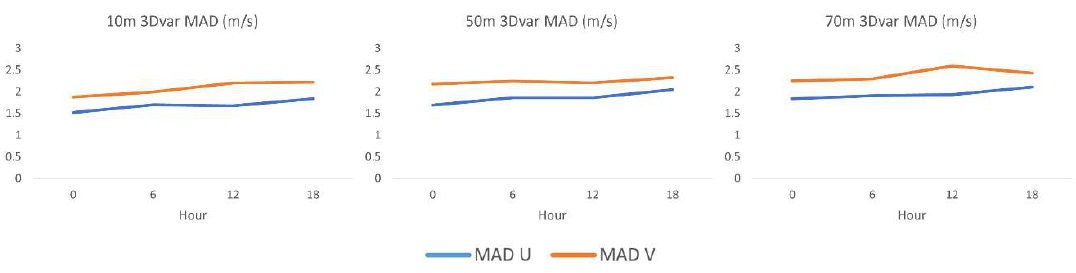
Figure 5. Mean absolute difference (MAD) of U (m/s) and V (m/s) at different heights (10, 50, and 70 m) in Test 2.